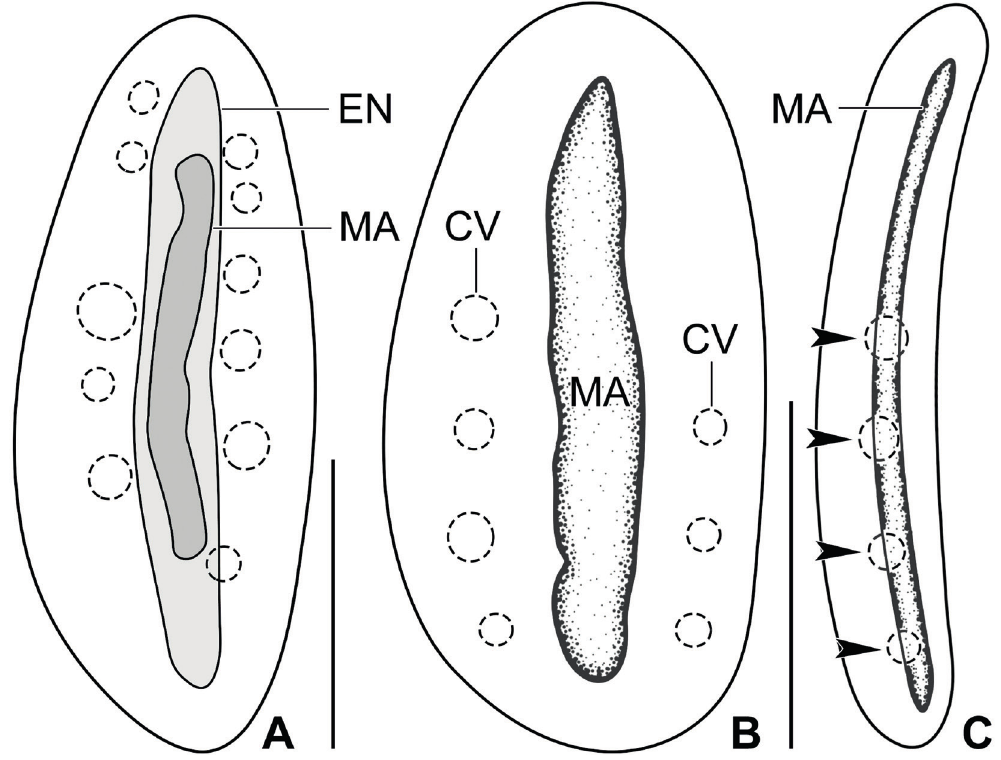
Fig. 12. Anoplophrya nodulata (Dujardin, 1841), Slovak specimens in vivo . A–B . Ventral views, showing the general body organization. The body is ovate with both ends rounded. The macronucleus is rod-like and extends through the cell’s midline. In dying cells, the macronucleus diminishes in size leaving behind a conspicuous hyaline envelope. There are two rows of contractile vacuoles, extending right and left of the macronucleus. C . Lateral view, showing the distinctly dorsoventrally flattened body. Arrowheads denote the right row of contractile vacuoles. Scale bars: 50